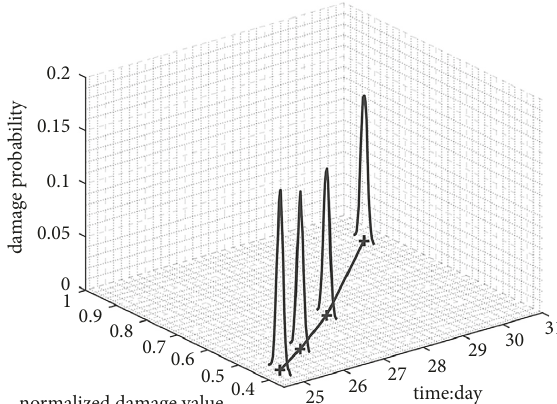
Figure 10: Distribution of the probability of damage prediction results.